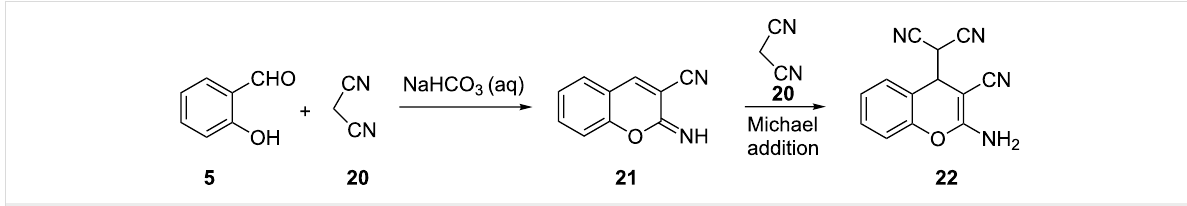
Scheme 8: Synthesis of 2-aminochromene 22 by Costa and co-workers.